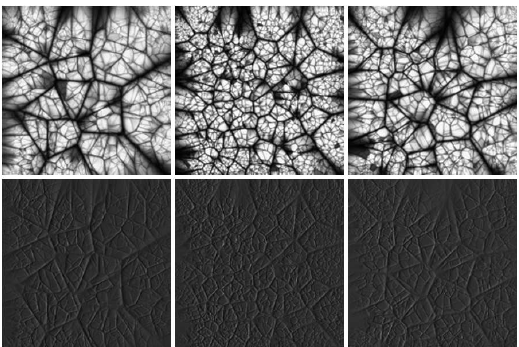
Figure 8. Textures generated using the Voronoi Diagram algorithm. First, row: height maps. Second row: relighting